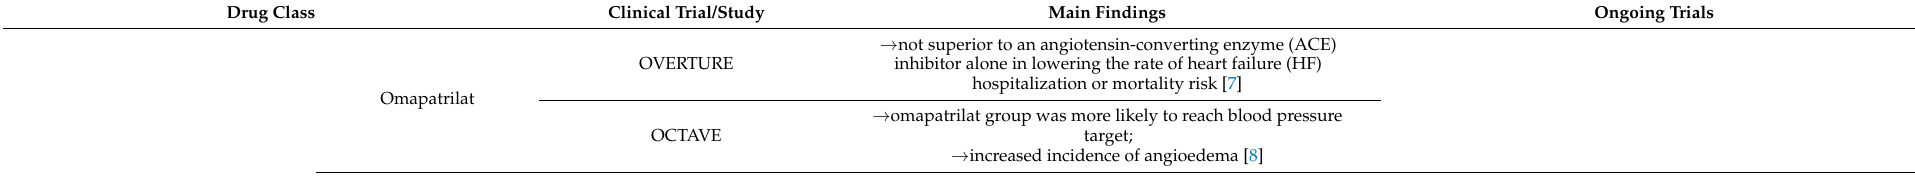
Table 1. Pharmacological therapies in